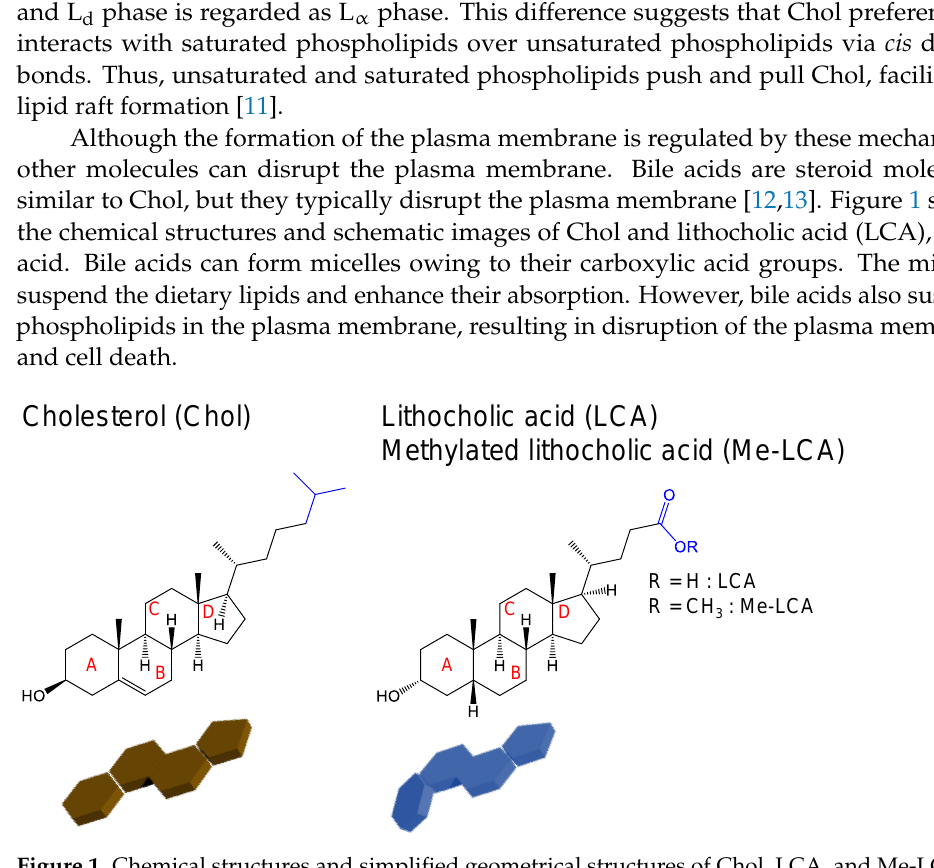
Figure 1. Chemical structures and simplified geometrical structures of Chol, LCA, and Me-LCA.